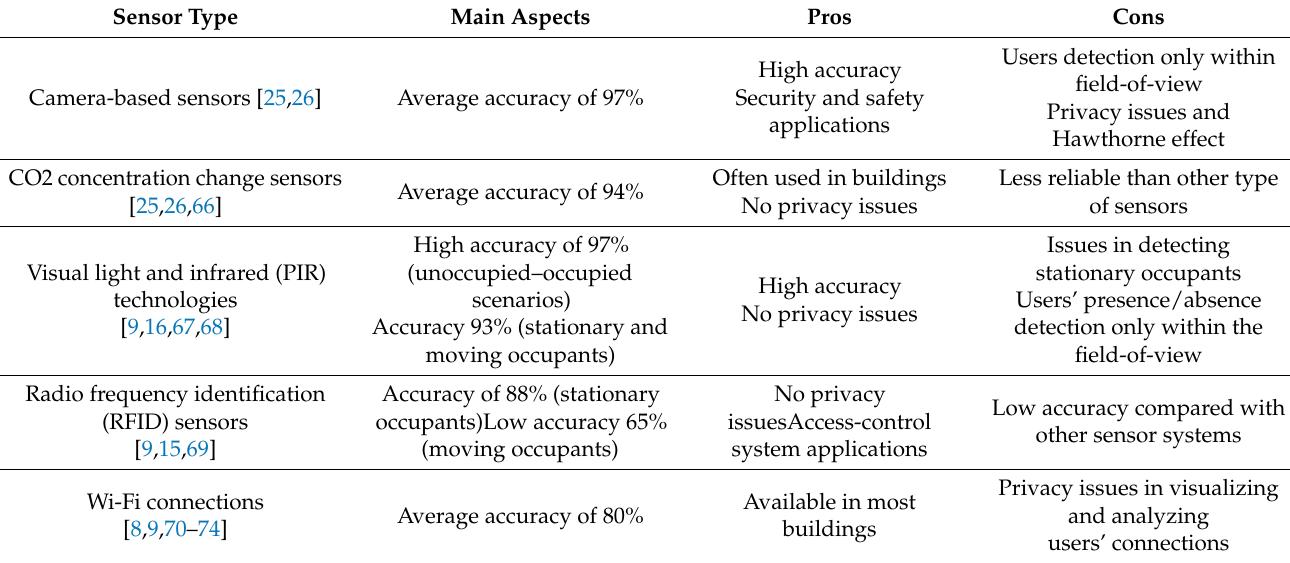
Table 1. Sensor systems and related features to monitor